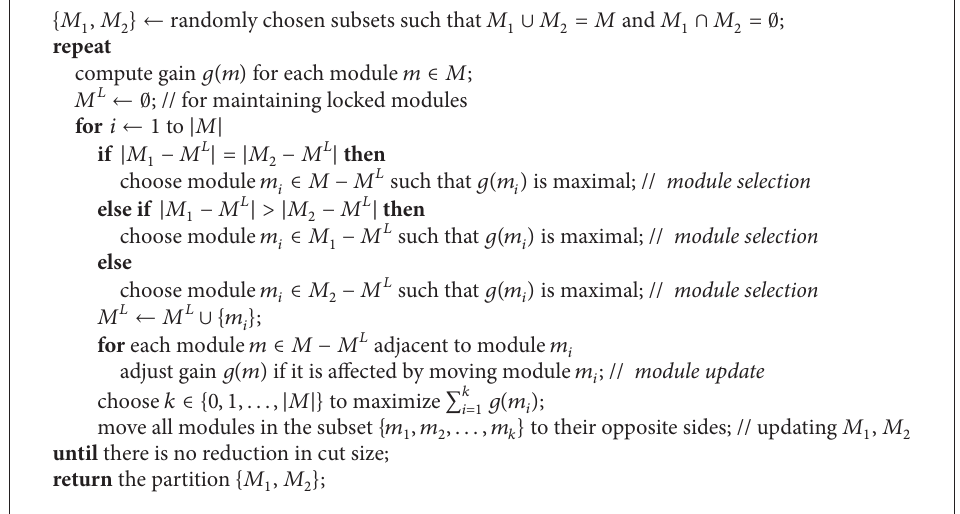
Algorithm 1: Pseudocode of the Fiduccia-Mattheyses iterative method. Note that the details of the above module selection and module update for each gain bucket management are given in Algorithms 2 and 3.